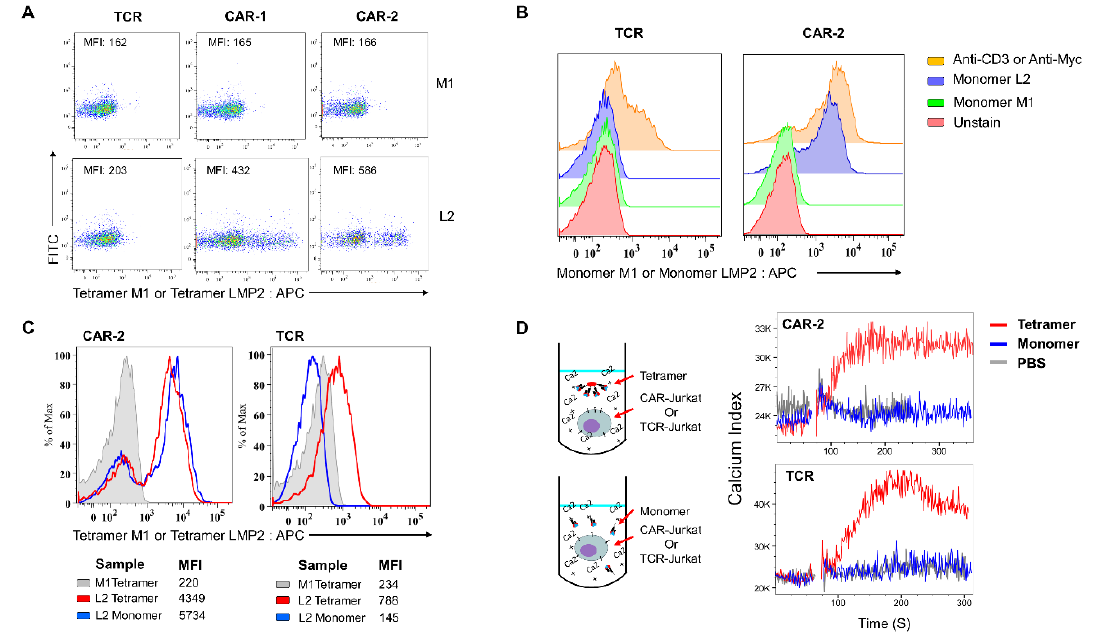
Figure 1. Monomer or tetramer binding and activation to the chimeric antigen receptor (CAR) and T cell receptor (TCR). ( A ) TCR and CAR binding to the specific peptide-major histocompatibility complex (pMHC) tetramer. CAR-1 and CAR-2 refer to first and second generation of CAR design, respectively. L2 and M1 represents the antigenic LMP2 A 426–434 (CLGGLLTMV) and irrelevant M1 58–66 (GILGFVFTL) peptide tetramer, respectively. The tetramer was formed by loading monomers with antigen presenting cell (APC)-streptavidin. Overall mean fluorescent intensity is labeled in the graph. ( B ) Monomer binding to CAR and TCR. The monomer binding was detected by using anti-B2 M APC. Anti-CD3-APC and Anti-Myc-APC were used to measure the expression of TCR and CAR on the surface, respectively. ( C ) Comparison of monomer and tetramer binding to CAR and TCR. ( D ) CAR and TCR activation upon monomer and tetramer binding. The schematic graph is shown at the left panel, the tetramer and monomer activation groups contained equal amounts of monomer. The Ca 2+ index was calculated by the ratio of the mean fluorescence intensity (MFI) of BUV395 to the MFI of Indo-1 (Bv421). The cells were stabilized for 1 to 1.5 min, followed by addition of the tetramer or monomer. The calcium flux was recorded for an additional 3–4 min. All data are representative of at least three independent experiments.